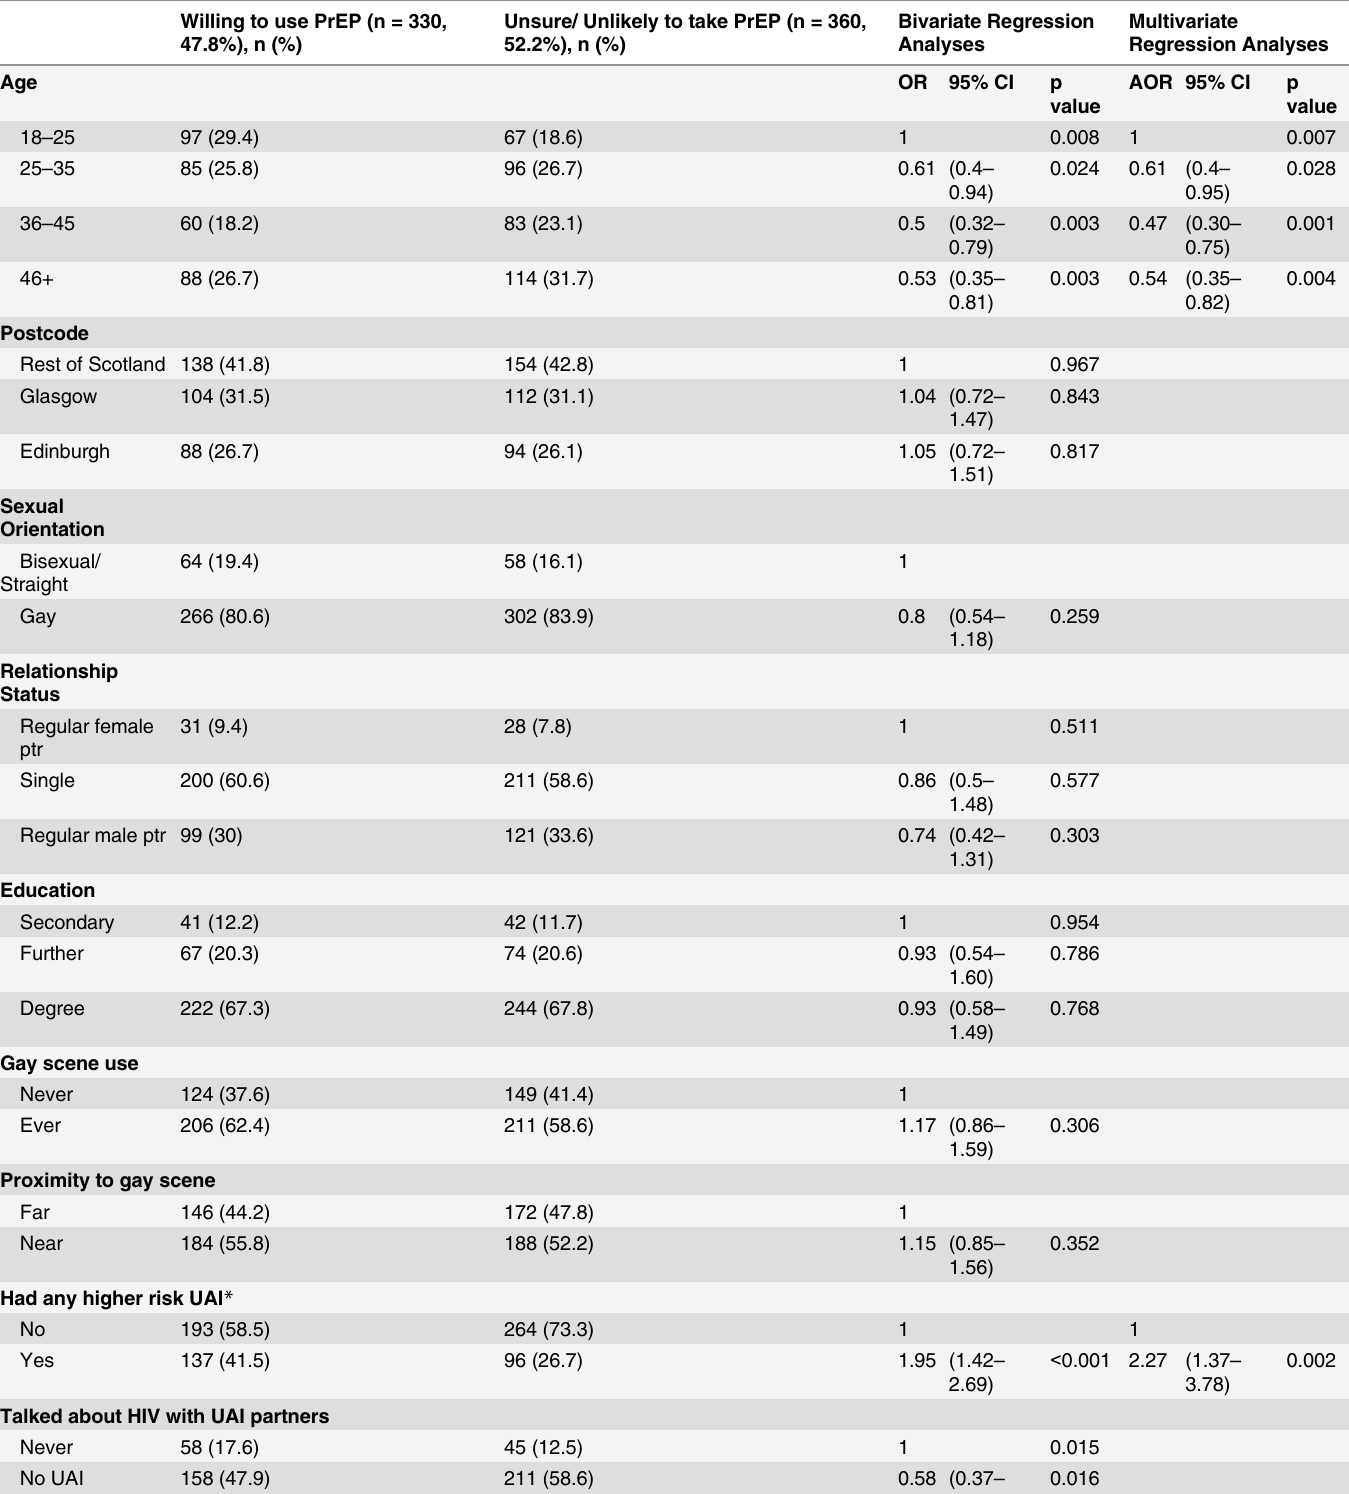
Table 3. Factors associated with the acceptability of PrEP use (N =